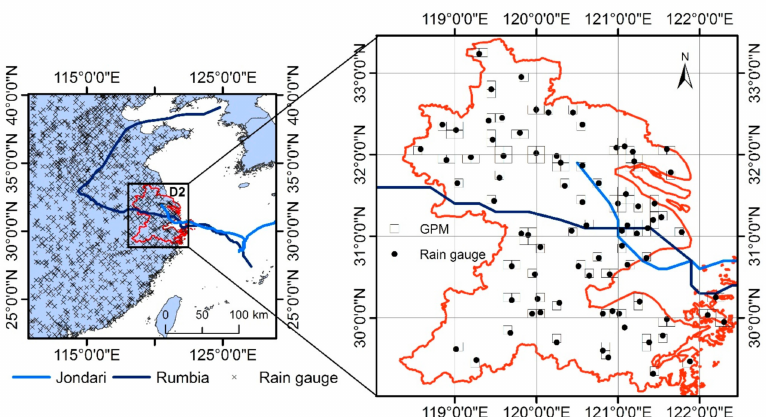
Figure 1. The location of the Yangtze River Delta region and rain gauges. Black dots represent the locations of the gauge stations. Black squares in the right figure represent the IMERG products gridboxs nearest gauge station. The blue and black lines represent the best track of Jondari and Rumbia with 6h interval, respectively. Track data is obtained from IBTrACS (ftp: // eclipse.ncdc.noaa.gov / pub / ibtracs / v04r00 / provisional / csv /